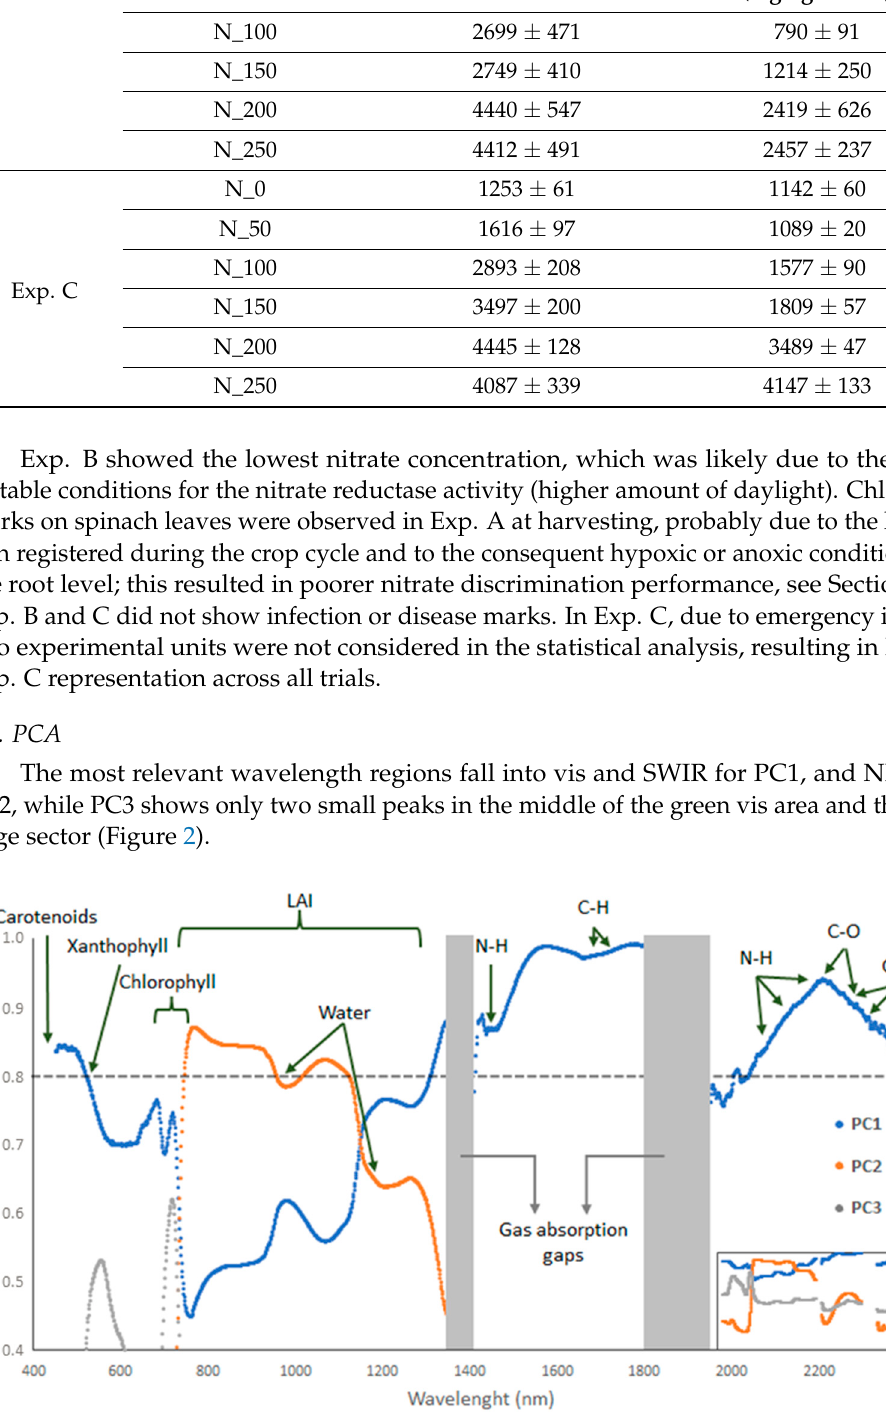
Figure 2. Graph of the loading values for PC1 (blue dots), PC2 (red dots), and PC3 (grey dots). The dashed horizontal line represents the chosen threshold, and the grey boxes are the bands wherein reflectance data have been omitted from the database, because of significant atmospheric effects. Arrows and braces indicate in which spectrum location there are known relationships with the presented features. For clarity, the entire graph, where the loadings axis span from − 1 to 1, is represented inside the box in the bottom right corner.